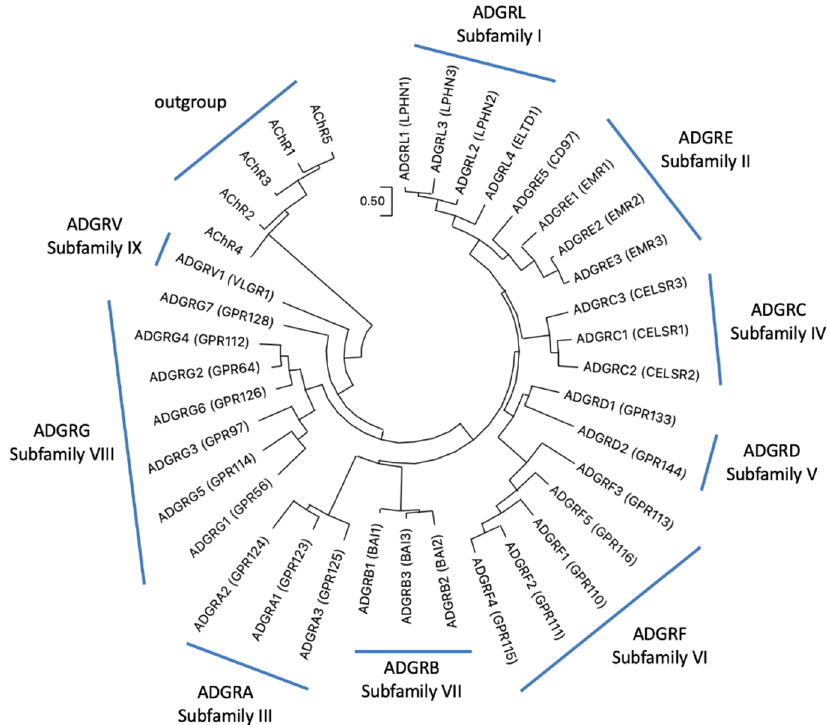
Figure 1. Phylogeny of human aGPCRs showing the current aGPCR subfamilies. The phylogenetic relation of human aGPCRs is shown and nine “subfamilies” were defined [9]. The evolutionary history was inferred by using the Maximum Likelihood (ML) method and JTT matrix-based model [16]. The tree with the highest log likelihood ( − 16982.54) is shown. Initial tree(s) for the heuristic search were obtained automatically by applying Neighbor-Join and BioNJ algorithms to a matrix of pairwise distances estimated using the JTT model, and then selecting the topology with superior log likelihood value. The tree is drawn to scale, with branch lengths measured in the number of substitutions per site. This analysis involved human 37 amino acid sequences with the five human muscarinic acetylcholine receptors as outgroup. There were a total of 368 positions in the final data set. Evolutionary analyses were conducted in MEGA11 [17,18]. The accession numbers are given in Suppl. Table S1.